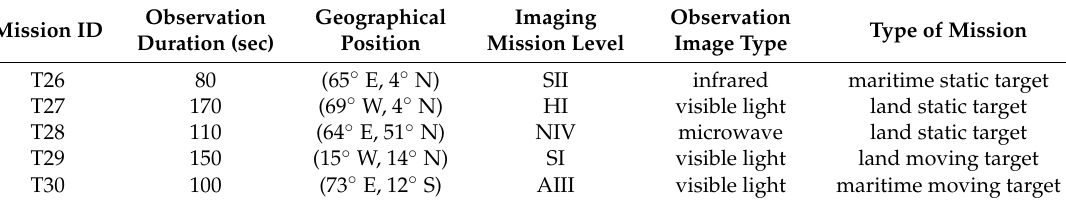
Table 6. Newly arrived mission parameters.